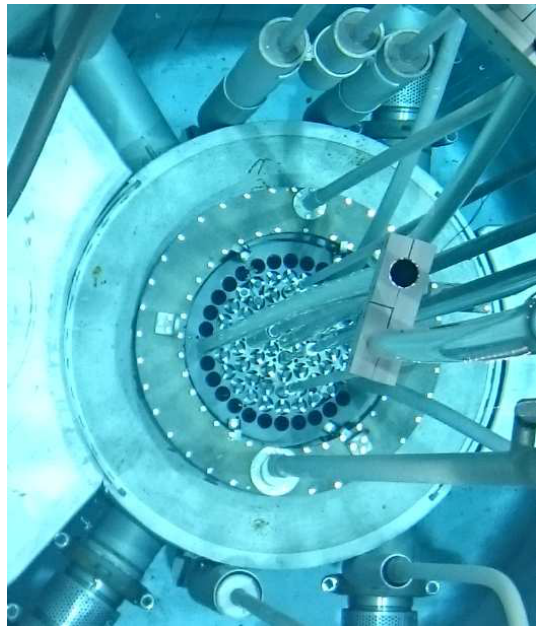
Figure 3: Underwater photograph of the TRIGA Mark II reactor core.